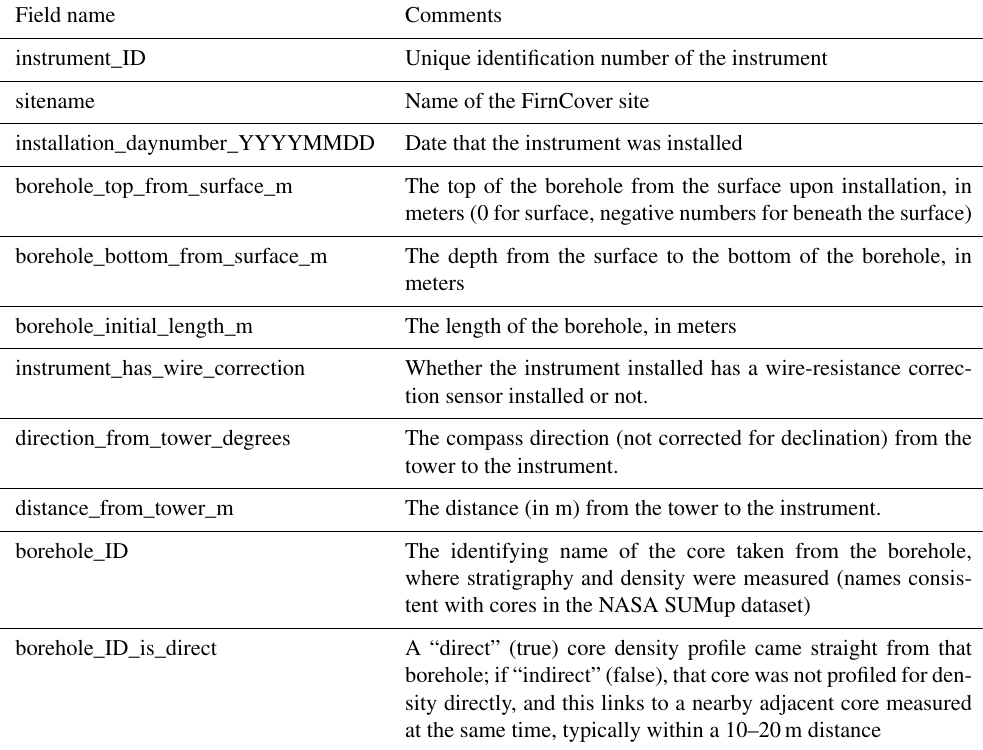
Table A7. Compaction_Instrument_Metadata table. Installation depths and positions of each FirnCover compaction instrument. Field